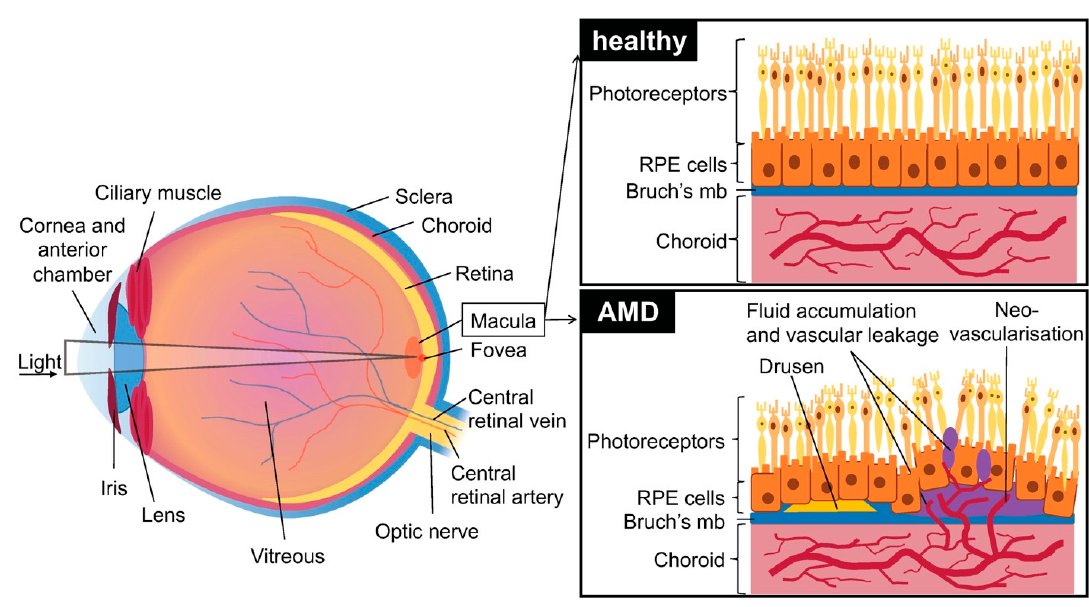
Figure 1. Schematic of the eye with healthy retina, choroid and retinal pigment epithelium (RPE) cells and effects of age related macular degeneration (AMD): presence of early drusen and neovascularization, disruption of Bruch’s membrane and RPE cells, and vascular leakage. Brusch’s mb = Brusch’s membrane.